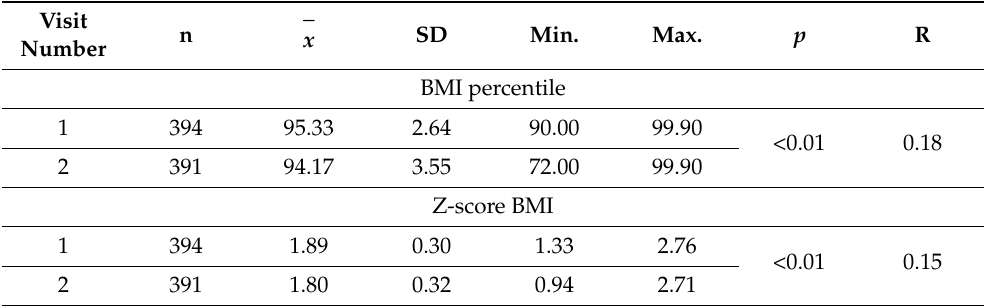
Table 4. Anthropometric parameters of children in group 2.